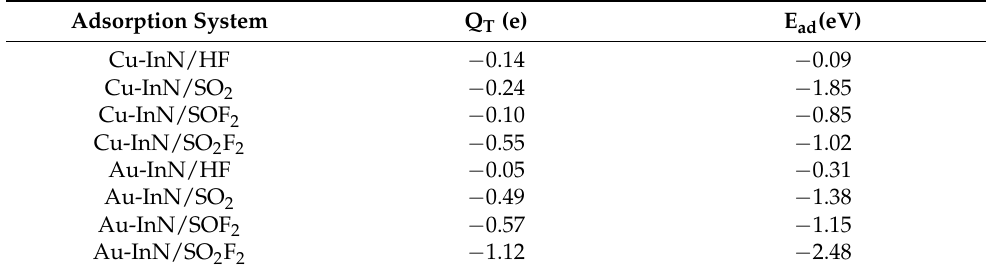
Table 4. The charge transfer (Q T ) and adsorption energy (E ad ) of Cu-InN/gas and Au-InN/gas